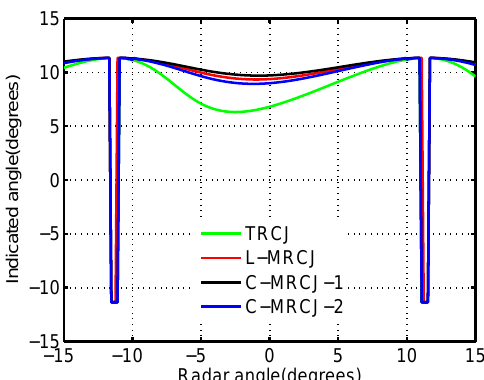
Figure 8. Monopulse-indicated angles of different jammer array configurations when the radar antennas rotate. The system parameters of TRCJ are − 0.5 dB and 180 ◦ , and the system parameters of L-MRCJ and C-MRCJ which are a 1 = a 3 = − 0.5 dB, a 2 = 0.5 dB, φ 1 = φ 2 = φ 3 = 180 ◦ .